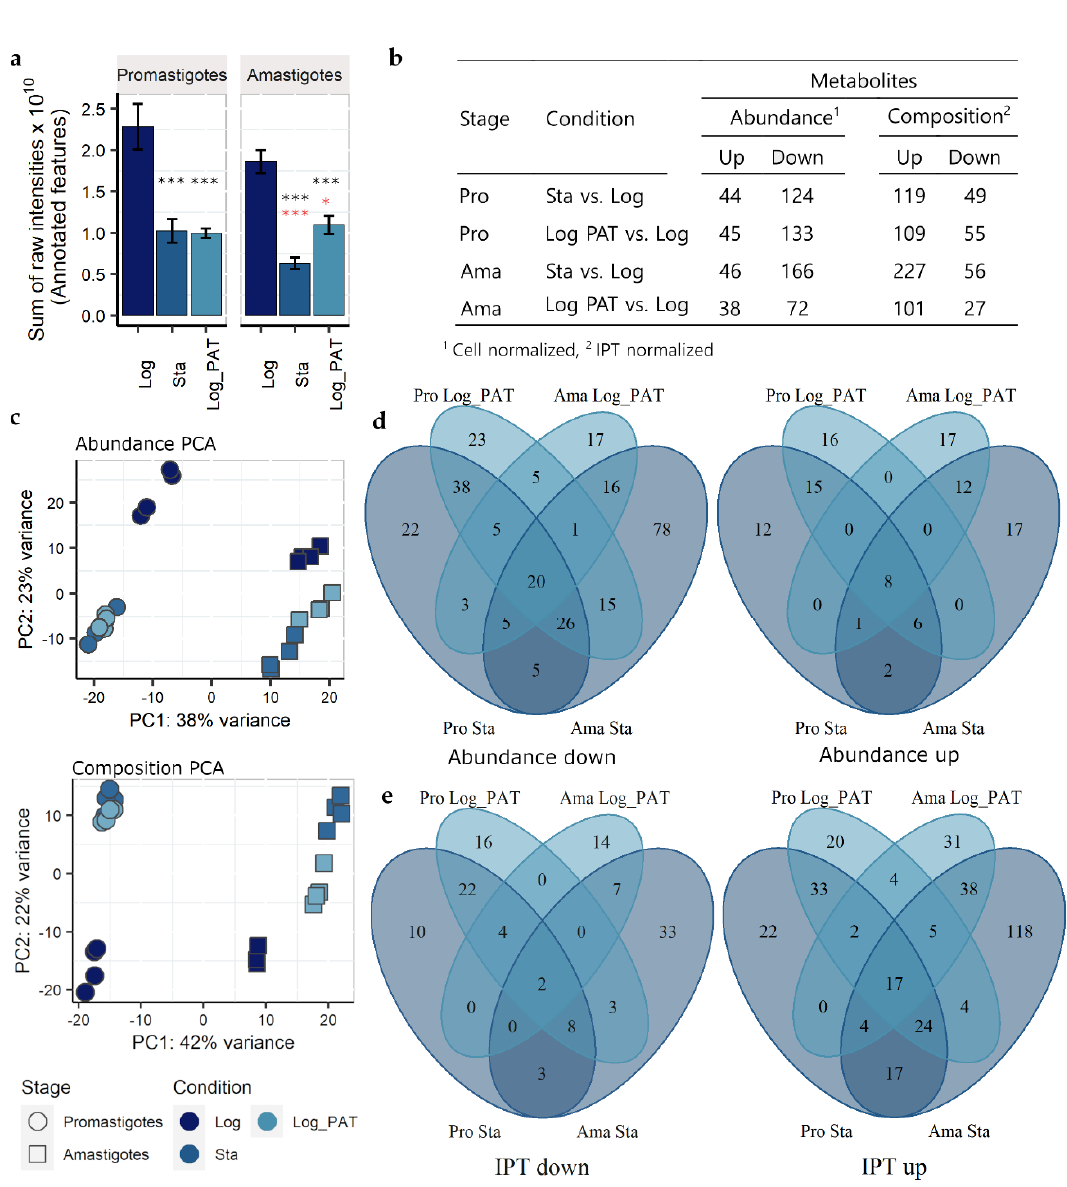
Figure 5. Quiescent cells have a distinct metabolic profile when compared to proliferating cells. The figures represent 689 putatively annotated metabolites. ( a ), In all quiescent cells of each Leishmania stage, there is an overall downregulation in the levels of metabolites (either in condition Sta or Log_PAT) as indicated by the decrease in the sum of the peaks intensities of all annotated features constituting their metabolome. The asterisks in the top of each bar in black color represent significant differences after Tukey’s test; * p < 0.05, *** p < 0.001. The asterisks in black and red represent differences in comparison to promastigotes and amastigotes in Log, respectively. ( b ), Summary of the number of modulated metabolites in quiescent cells induced by condition Sta or Log_PAT in both promastigotes and amastigotes. The results after normalizing by an equivalent amount of cells or by IPT are shown (cutoff |log2 FC| > 1 and BH adjusted p < 0.05). ( c ), Quiescent cells in both stages have a distinct metabolic profile, as indicated by the clear separation of quiescent and non-quiescent cells by the PCA 2. ( d , e ), Venn Diagrams showing the relationship between the set of modulated metabolites (panel b ) across the different conditions and stages of the Leishmania . Pro, promastigotes; Ama, amastigotes.